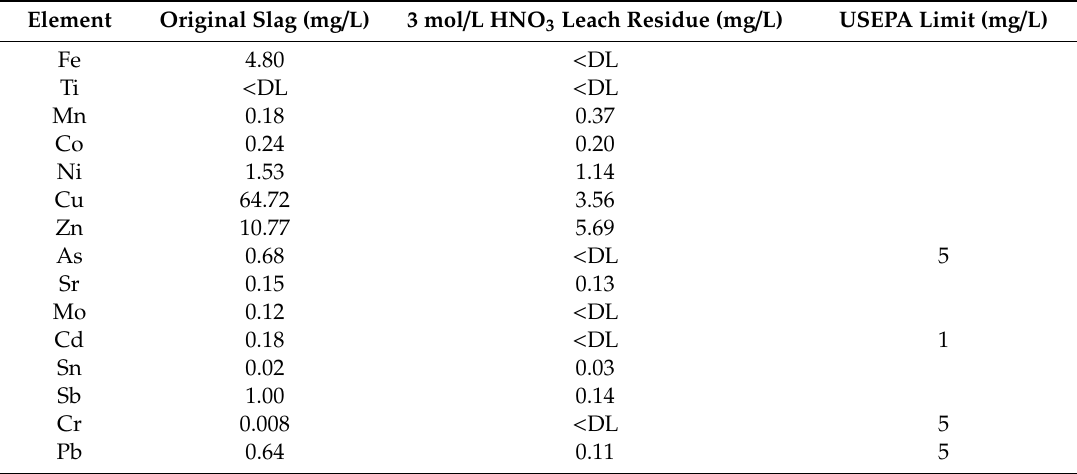
HNO 3 (DL: detection